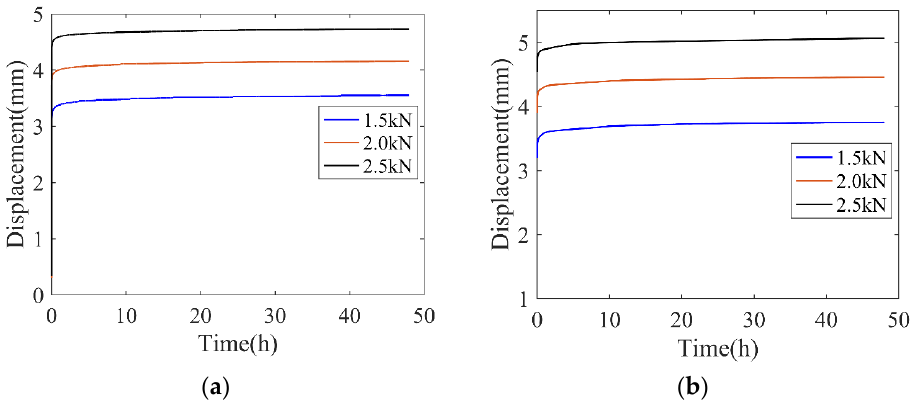
Figure 5. Experimental creep history for rubber materials. ( a ) 23 °C and ( b ) 55 °C.